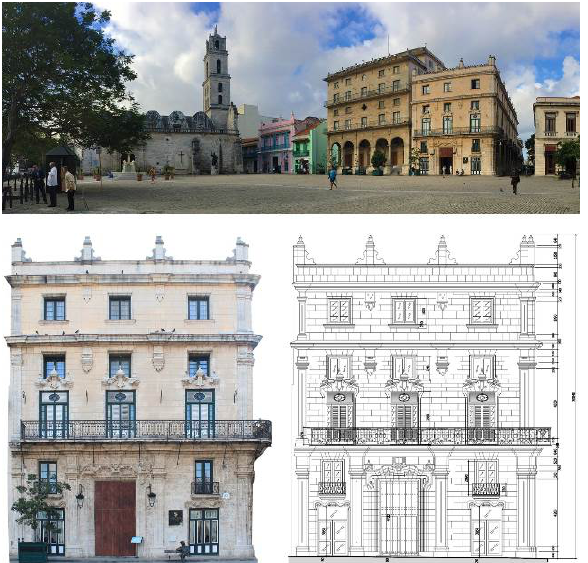
Figure 12. 2D photo plane creation (building in Plaza de San Francisco)